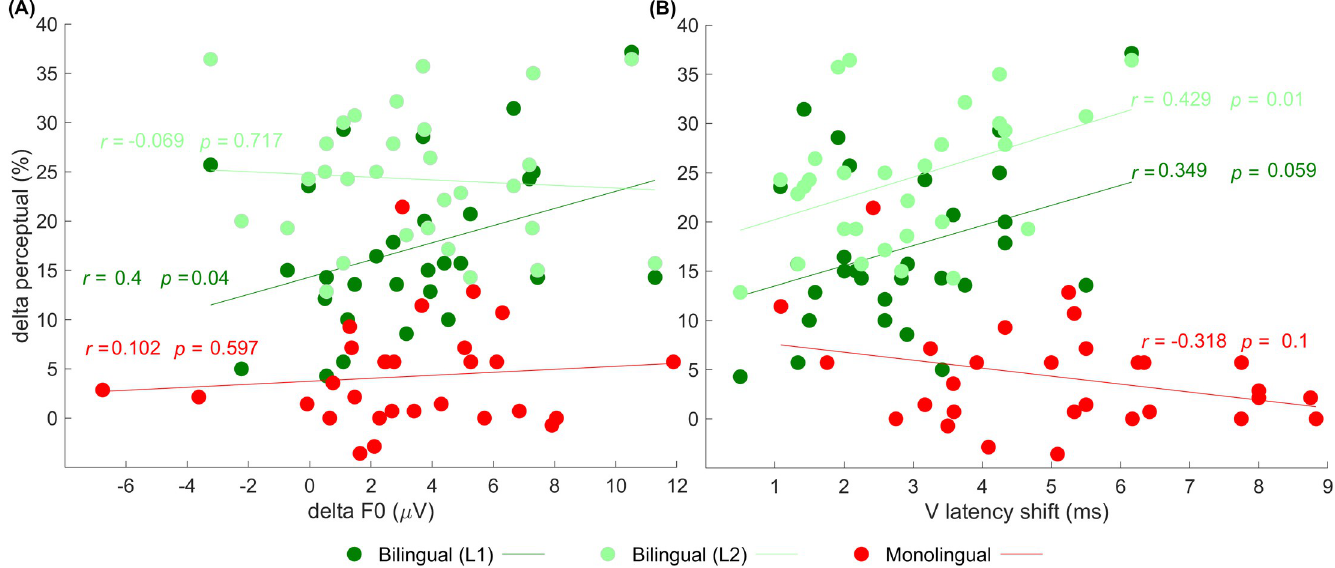
Fig 3. Physiological and behavioral relations. Deterioration in perceptual accuracy (delta perceptual = accuracy in quiet minus accuracy in noise; y-axis) as a function of changes in F0 amplitude (delta F0 = F0 amplitude in quiet minus F0 amplitude in noise; x-axis in (3A)) and shifts in V latency (V latency shift = V latency in noise minus V latency in quiet; x-axis in (3B)). Pearson r coefficient values and p values for bilingual L1 (dark green), bilingual L2 (light green), and for the monolingual group (red) are